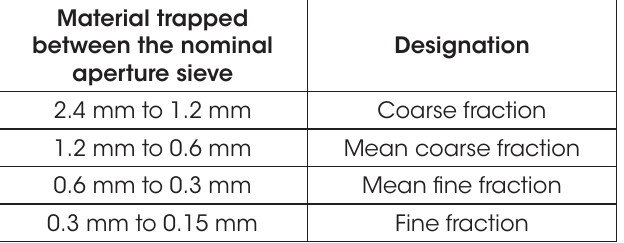
Grain size fractions standard sand Material trapped between the